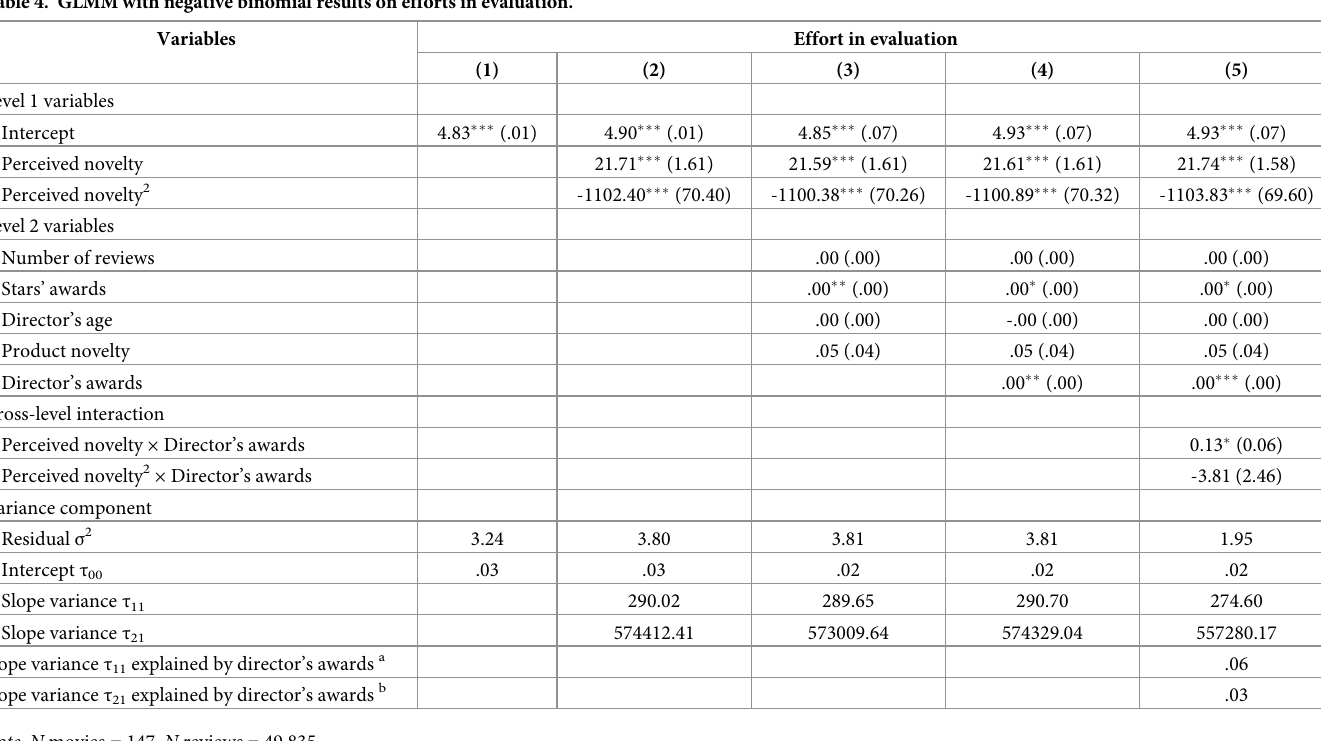
Table 4. GLMM with negative binomial results on efforts in evaluation.